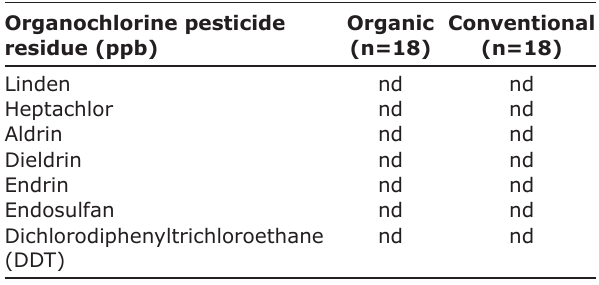
Table-3: Organochlorine pesticide residues in organic goat milk and conventional goat milk. Organochlorine pesticide residue (ppb)